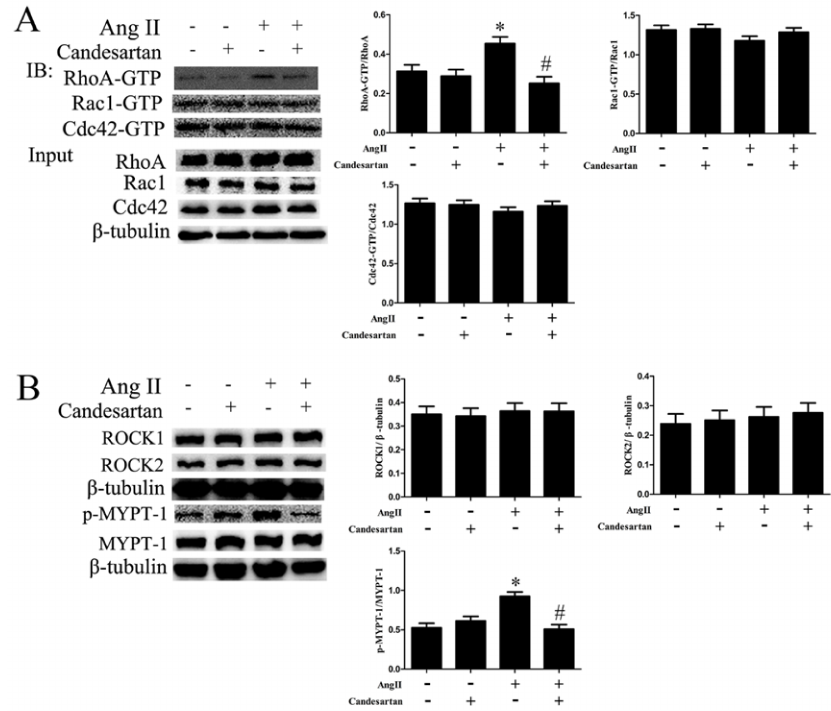
Figure 3. The e ff ects of AT1 receptor inhibitor candesartan on the expression and activation of Rho GTPases and Rho-associated kinase (ROCK). Cells were pretreated with candesartan (5 µ M) for 6 h and then exposed to 100 nM Ang II for 24 h. Untreated cells were used as the control. ( A ) Detection of Rho GTPases activity by pulldown assay. Histograms show the ratios of Rho GTPases GTP-bound to total Rho GTPases. * p < 0.05, vs. the control group; # p < 0.05 vs. the Ang II-treated group ( n = 3). ( B ) Western blot analysis of the expression of ROCK1, ROCK2, MYPT1, and phospho-MYPT1 (Thr696). Histograms show the ratios of ROCK1 or ROCK2 to β -tubulin or phospho-MYPT1 to total MYPT1. * p < 0.05, vs. the control group; # p < 0.05 vs. the Ang II-treated group ( n =